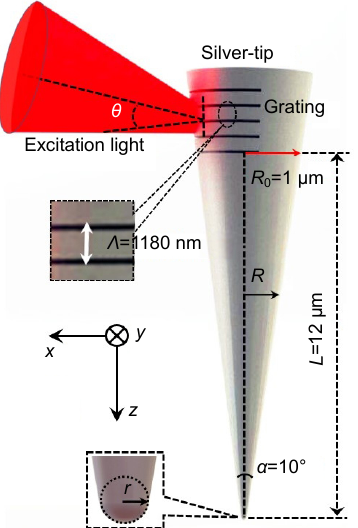
Fig. 1 | Geometry of a conical silver tip with grating-assisted light coupling . The excitation light is focused onto the diffractive grating. R is the cross-sectional radius of the tip body gradually decreasing from 1 μ m to 20 nm. The tip apex is modeled as a hemisphere with a radius of r